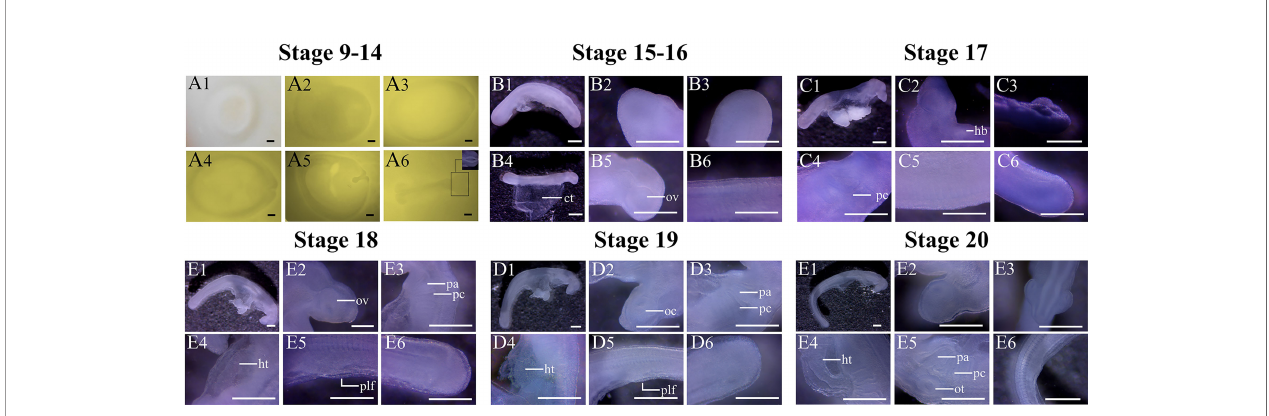
FIGURE 3 | Key characteristics of O. kenojei embryos in developmental stages 9 – 20. Bar = 0.05 cm. ct, connective tissue; hb, heart bulge; oc, optic cup; ov, optic vesicle; ot, otic placode; pa, pharyngeal arch; pc, pharyngeal cleft; plf, pelvic fi n.